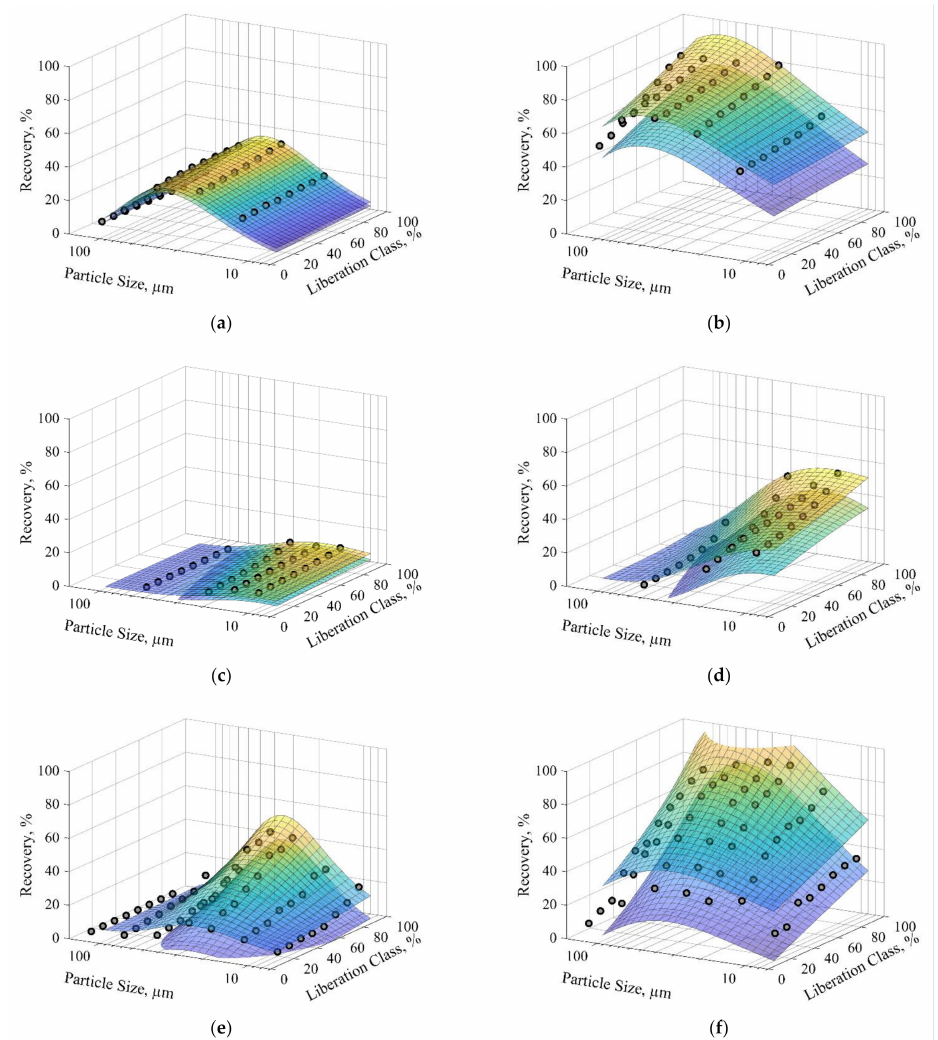
Figure A1. 95% prediction intervals for the size-by-liberation galena recoveries: Vianna [8] ( a ) 5 g/ton of Aerophine 3418A, ( b ) 30 g/ton of Aerophine 3418A; Savassi [13] ( c ) 2 cells in series, ( d ) 12 cells in series; and Welsby [9] ( e ) 5 g/ton of Sodium Ethyl Xanthate, ( f ) 40 g/ton of Sodium Ethyl Xanthate. Experimental data are presented as datapoints and prediction intervals as 3D surfaces. Middling particles (10–90% liberation). Particle size axes are in